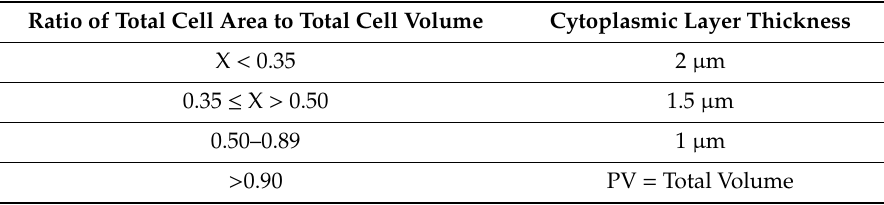
Table 1. Correction of Plasma Volume (PV) for Cell